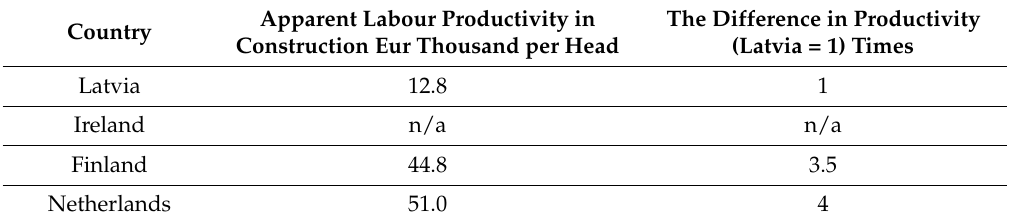
Table 3. Apparent labour productivity in construction 2013